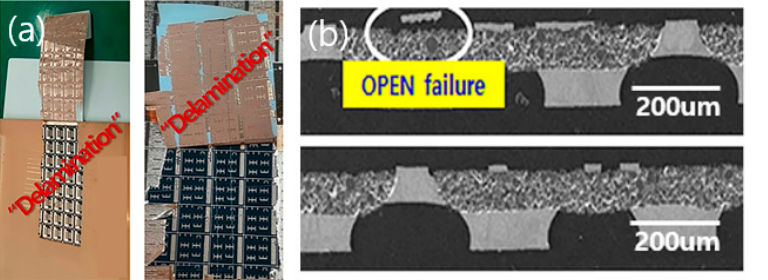
Figure 2. Example of Cu layer peeling failure: ( a ) Delamination of Cu layer on resin surface; ( b ) SEM image for the resulting open failure.